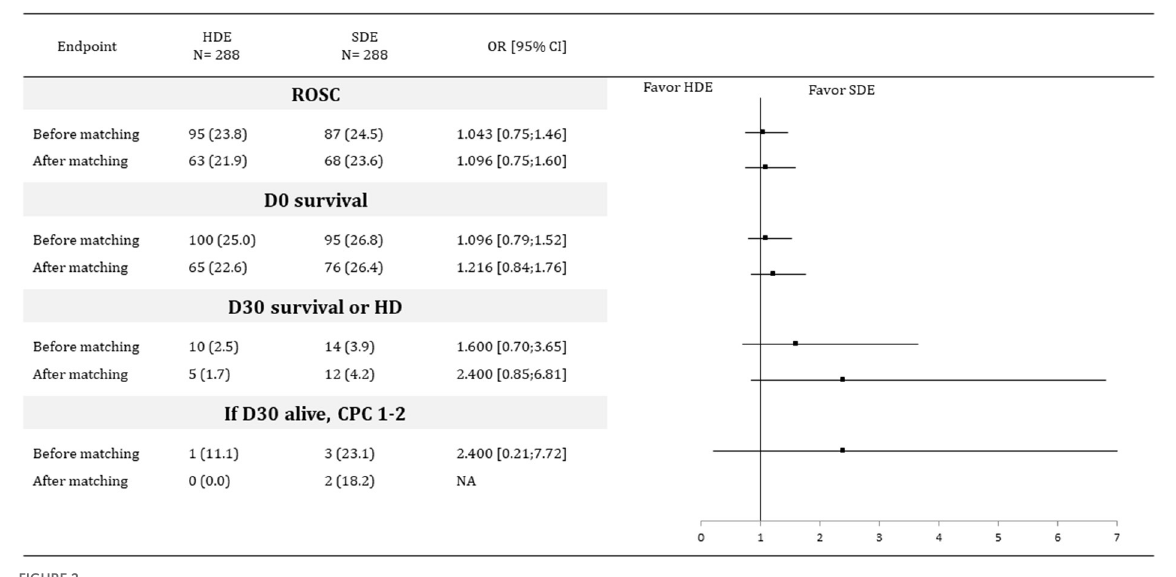
FIGURE2 Outcomes before and after propensity score matching. HDE, high dose of epinephrine; SDE, standard dose of epinephrine; OR, odd ratio; CI, confidence interval; CPC, cerebral performance categories; D30, 30 days after ROSC; HD, hospital discharge; OR, odds-ratio; ROSC, return of spontaneous